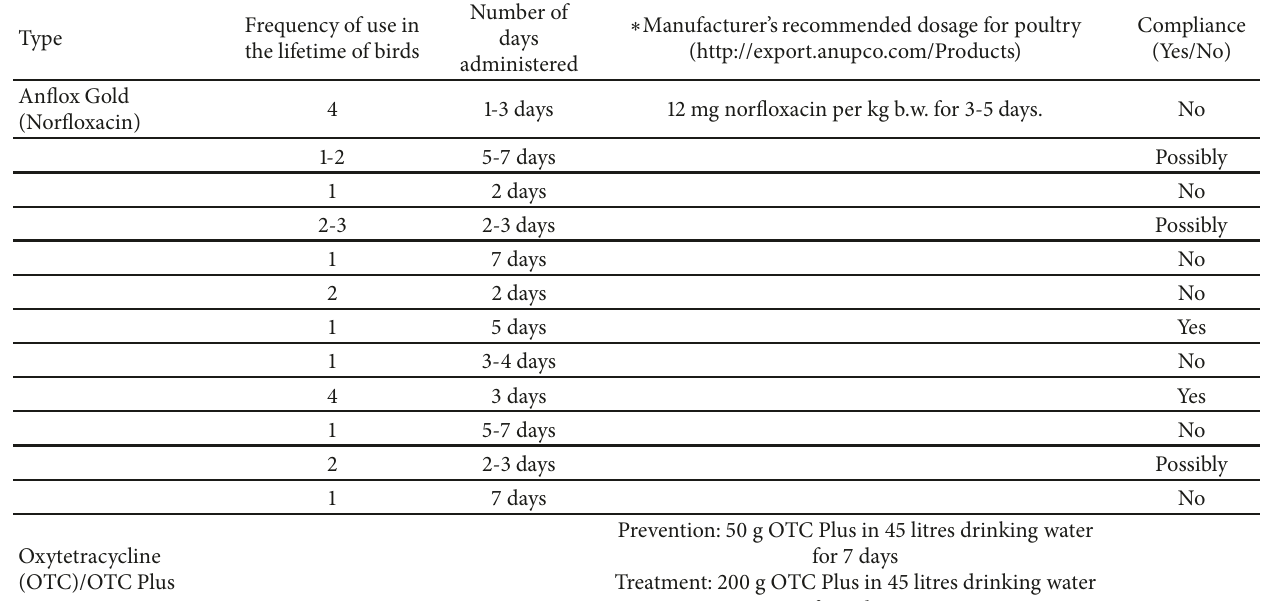
Table 3: Duration of Administration of Antibiotics by Poultry